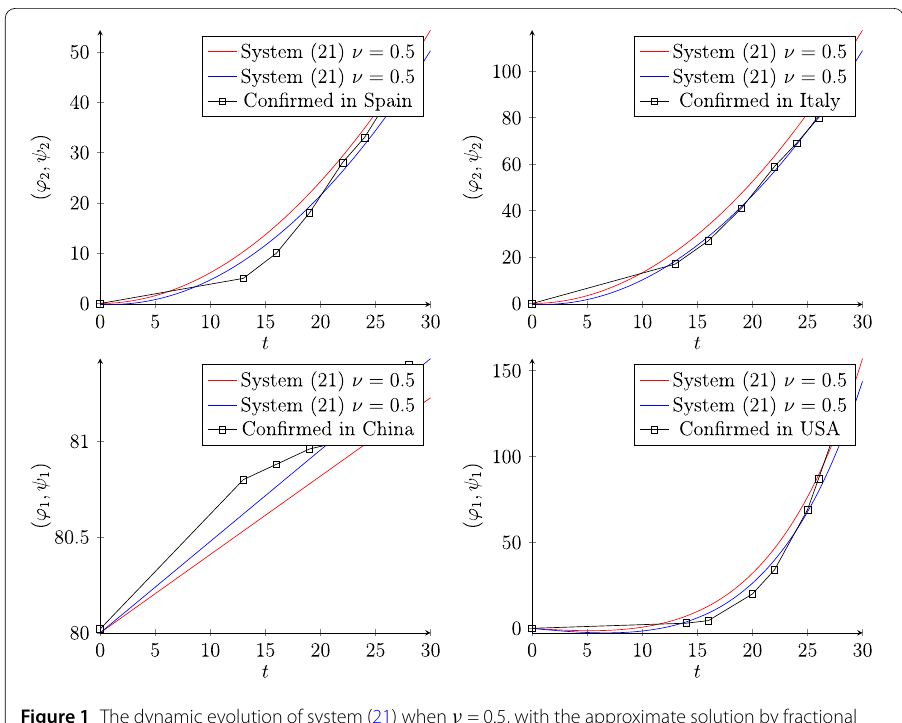
Figure 1 The dynamic evolution of system (21) when ν = 0.5, with the approximate solution by fractional Chebyshev polynomials ( ϕ 2 , ψ 2 ) = ( 2( t +2 t 2) π , 2( t +2 t 2) π ) for Spain and for Italy with different coefficients C 0.5,2 . China statistics in March has steady circulation; consequently, we propose ( ϕ 1 , ψ 1 ) = ( 2 t +2 π , 2 t +2 π ). For USA data, the chart shows high rising confirmed cases, therefore we apply exponential connections ϕ